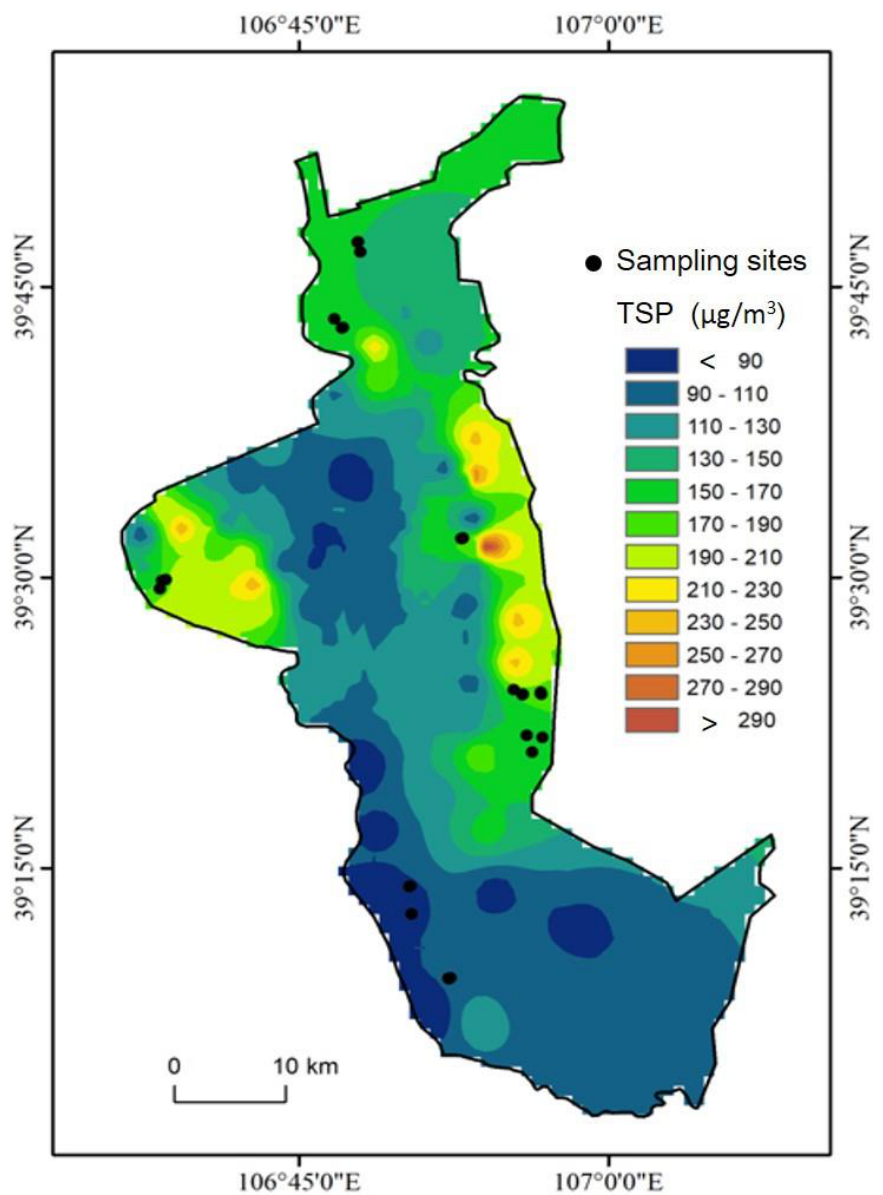
Figure 2. Distribution of total suspended particulate matter in city of Wuhai.